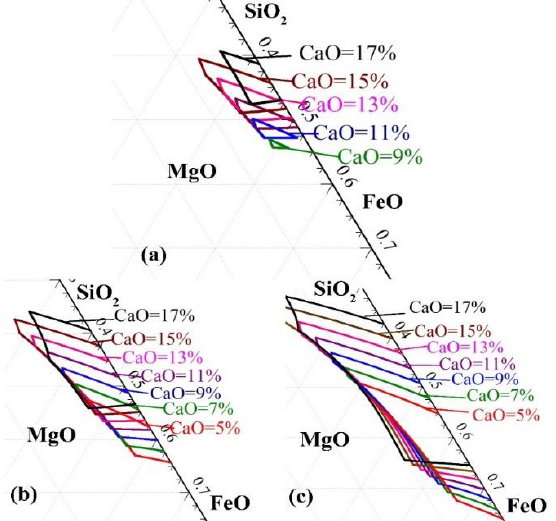
Figure 2. Superposition diagram of liquidus region of Fe x O-SiO 2 -CaO-MgO-“NiO” ( a ) 1200 °C; ( b ) 1250 °C; ( c ) 1300 °C.